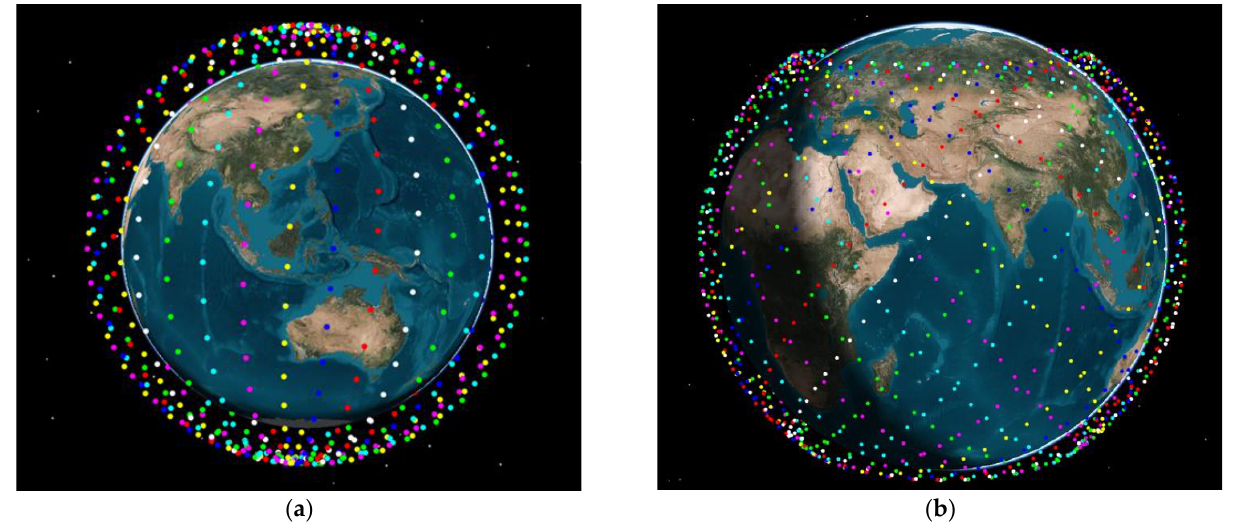
Figure 7. Modeling diagram of Starlink and OneWeb constellation (Data on the orbits of satellites in the constellation are detailed in the link in the Supplementary Materials). ( a ) OneWeb constellation; ( b ) Starlink